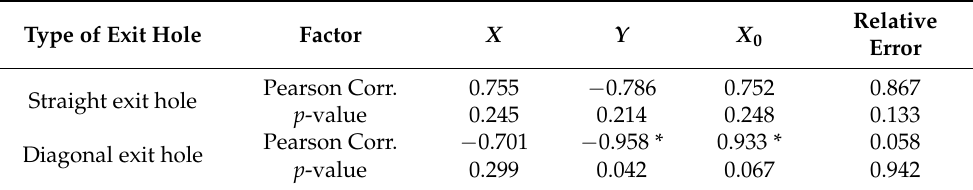
Table 3. Analysis results of correlation between tilt angle of the exit hole and the grain collision point coordinates and sensor indication error in experimental tests.